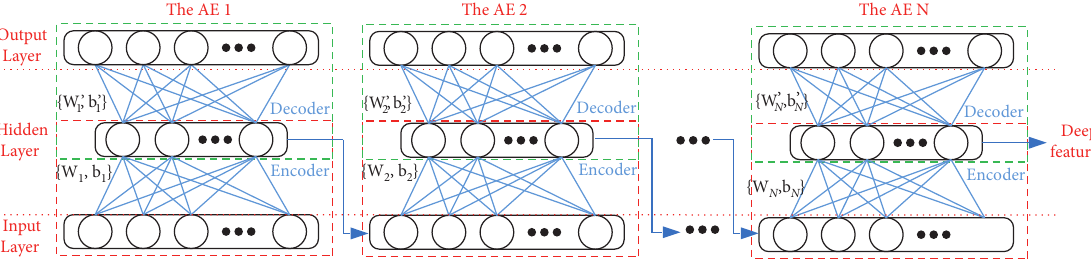
Figure 2: The structure of DAE.